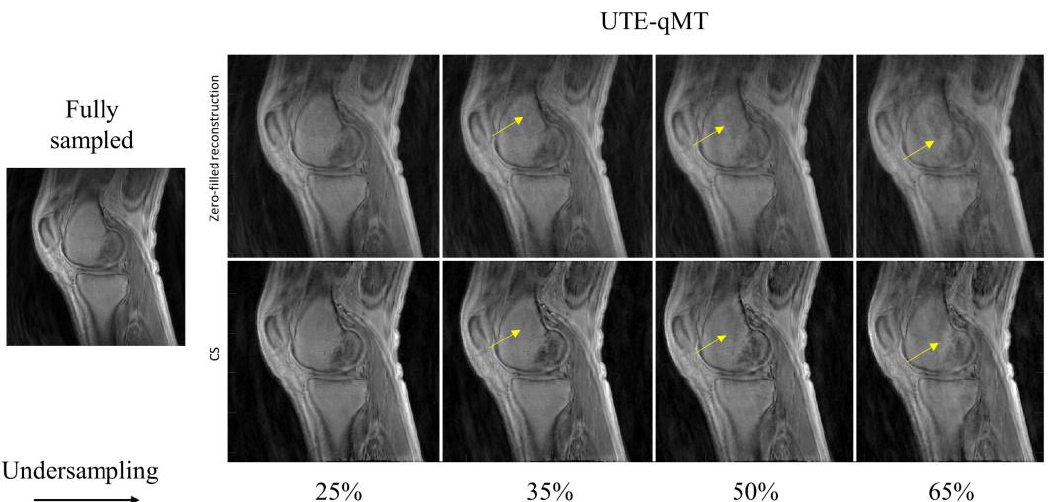
Figure 4. Comparison between zero-filling-based reconstruction ( top row ) and CS-based reconstruction ( bottom row ) for UTE-qMT at different undersampling rates (25%, 35%, 50%, and 65%). The arrows point towards the streaking artifacts and blurring present in the reconstructed images with zero-filling, which is reduced with CS. Table 2. This comparison of zero-filled (ZF) and CS reconstruction using MSSIM measure at various undersampling rates. MSSIM values for various flip angles of UTE-T 1 show that with increase in undersampling rate, MSSIM falls below 0.9 for CS images and much lower value (~0.7) for ZF- reconstructed images. For MSSIM metric value of UTE-Adiab-T 1 ρ at different spin lock times,